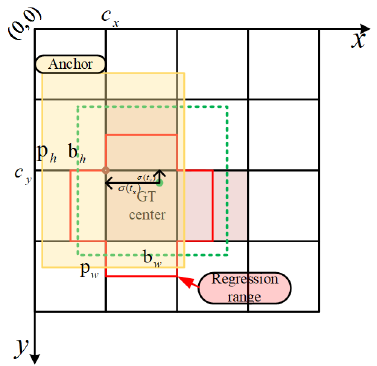
Figure 12. Definition of positive samples in the training process. The bounding box regression ( b x , b y , b w , b h ) is defined by Formula (7), where ( c x , c y ) is the upper left vertex of the gt grid, ( t x , t y ) is the gt center offset, t w and t h are the gt width and height offsets, respectively, and p w and p h denote the width and height of the anchor. The range of the bounding box regression center is ( − 0.5~1.5), which corresponds to the red bounding box in Figure 12.